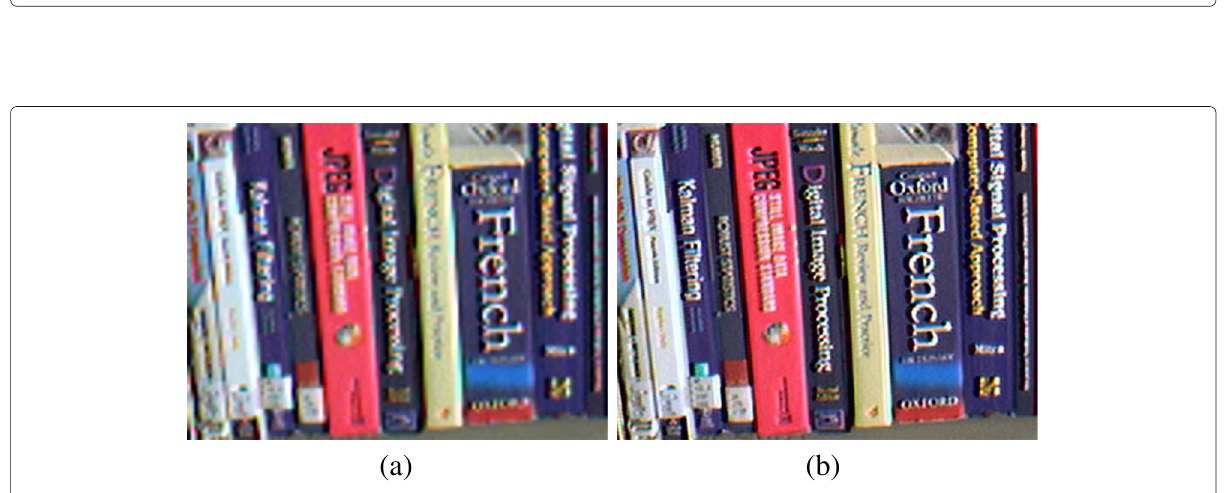
Fig. 6 The RMSE evolving with the time steps in random orders. The noise variances of all LR images are 20. Each line corresponds to a different order of the LR images